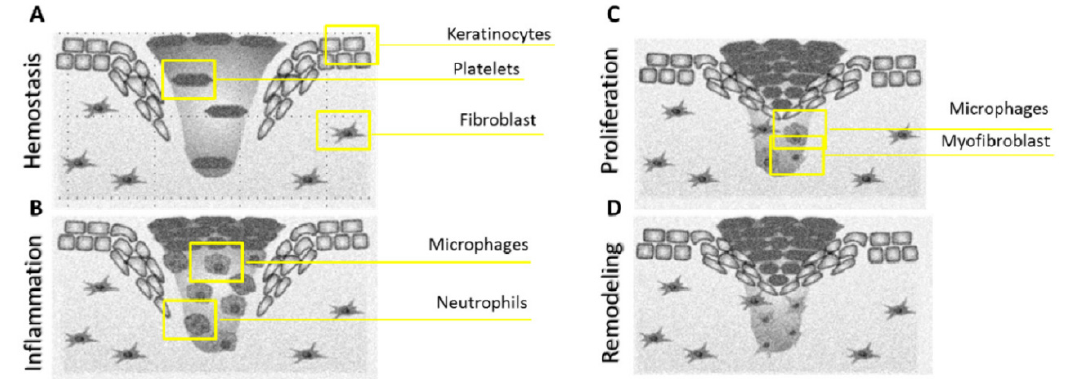
Figure 2. Wound healing process and cells involved in each phase: ( A ) hemostasis, ( B ) inflammation, ( C ) proliferation, ( D ) remodeling [19] .